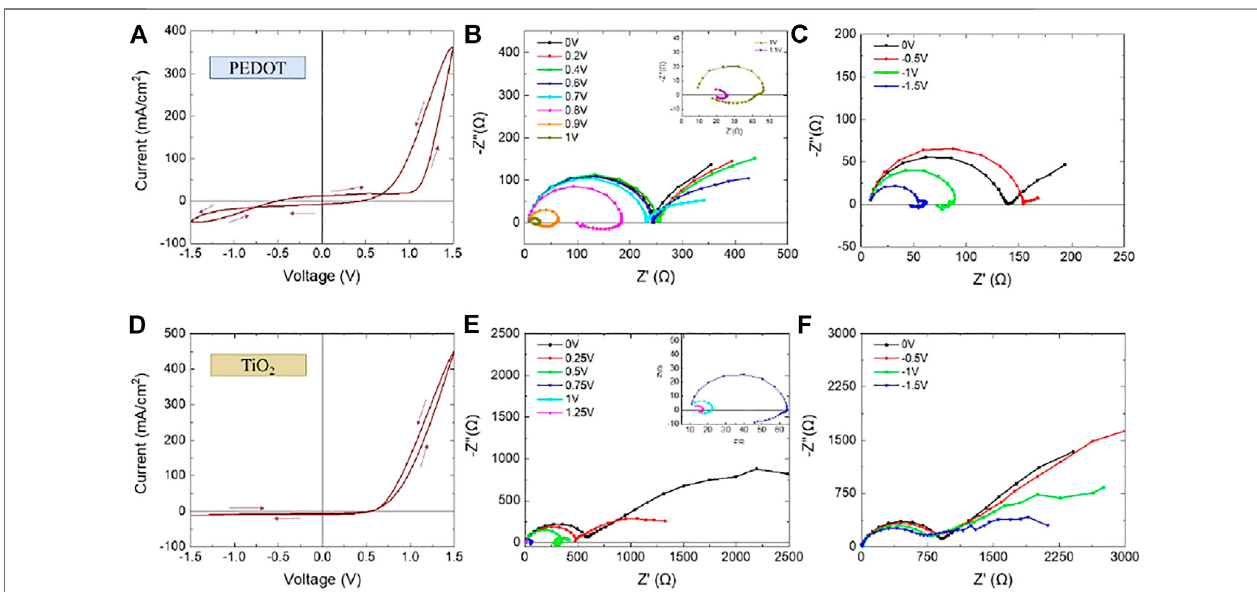
FIGURE 11 | (A) Current density − voltage characteristic measured at 50 mW/cm 2 blue light illumination for an FTO/PEDOT:PSS/MAPI/Au memristor. Arrows indicate sweep direction. (B – C) Corresponding complex plane plot representation of the impedance spectra at various dc voltages, measured from 1MHz to 0.1 Hz. Inset corresponds to higher dc voltages applied. (D) Current − voltage characteristic measured at 50 mW/cm 2 blue light illumination for an FTO/c-TiO 2 /m-TiO 2 /MAPI/Au memristor. (E – F) Corresponding complex plane plot representation of the impedance spectra at various dc voltages.